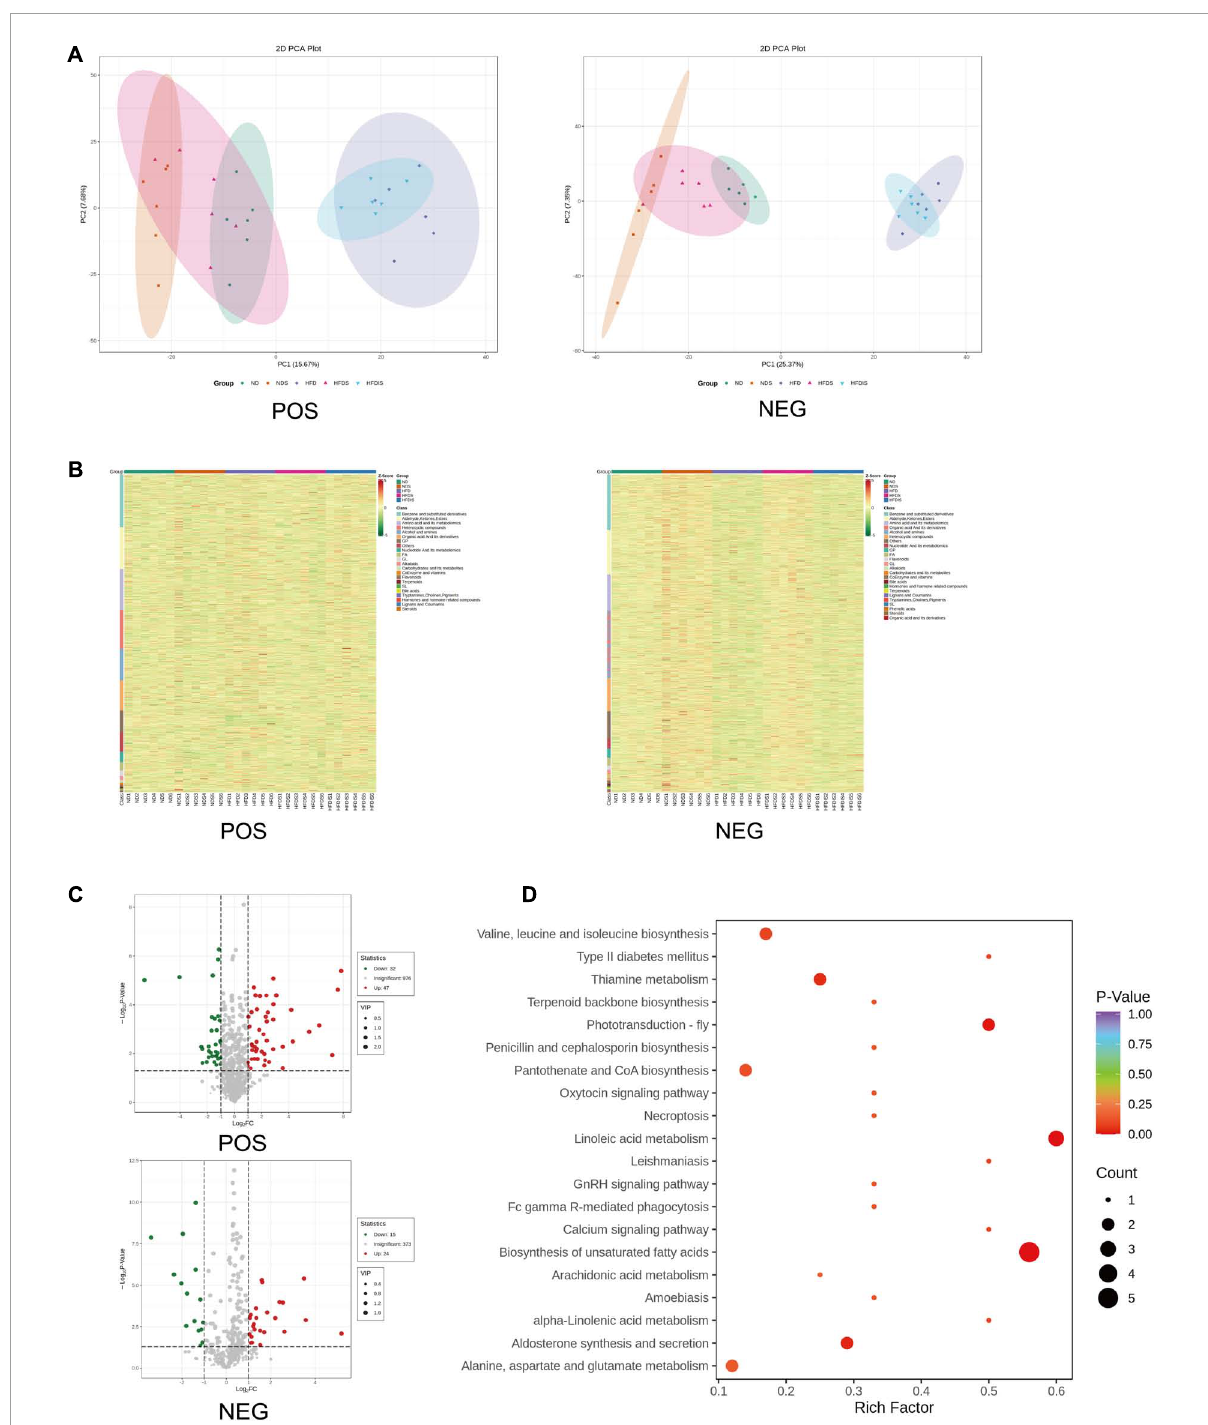
FIGURE4 Differential metabolites were identified and analyzed using metabonomics in the liver of HFD-Fed rats. POS indicates metabolites with positive ions in the mass spectrum, NEG indicates metabolites with negative ions in the mass spectrum. (A) Results of metabolites principal component analysis (PCA) of all liver samples. (B) Cluster chart of differential metabolites. Red and green represent significant upward and downward adjustments, respectively. (C) Volcano map for the HFDS vs. HFD group. The red and green dots represent significantly up- and down-regulated differential metabolites, respectively. (D) Bubble plot of the top 20 KEGG enrichment pathways of differential metabolites. Rich Factor is defined as the number of differential metabolites annotated to the pathways divided by all identified metabolites annotated to the